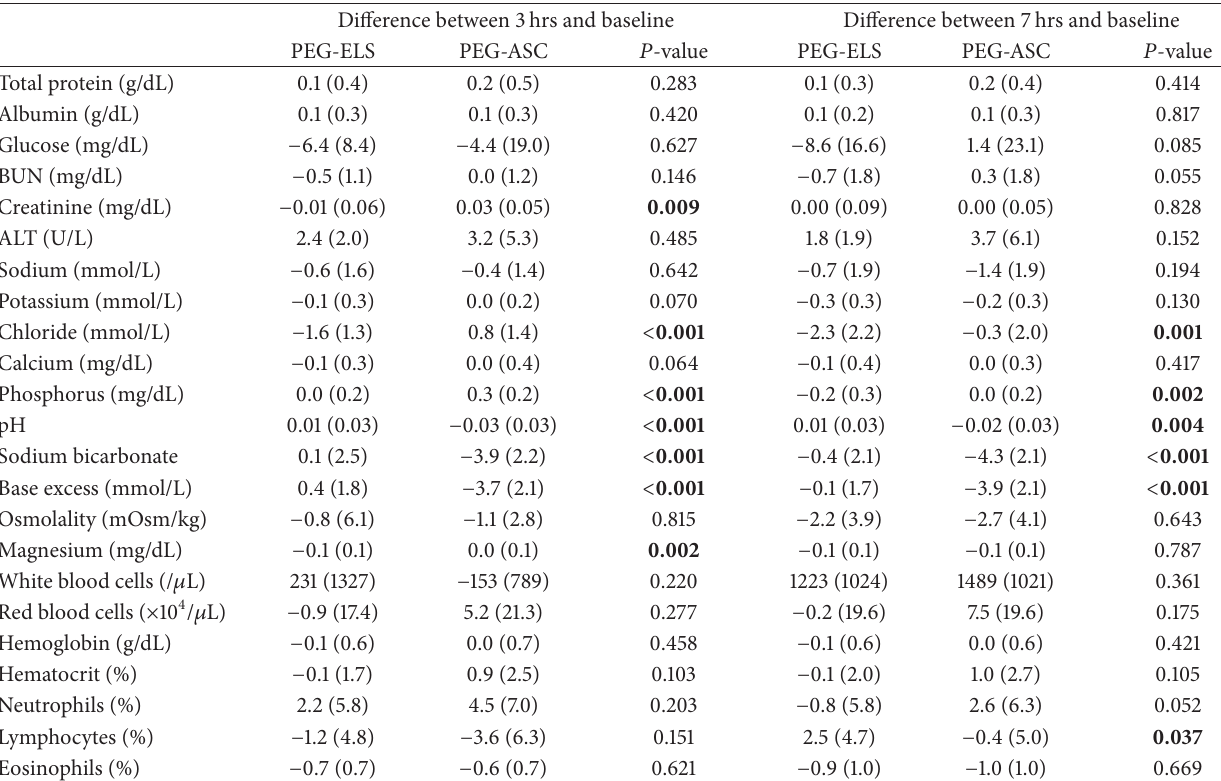
Table 6: Differences in laboratory results between baseline and 3 hours and 7 hours after taking gut lavage solution in patients aged 70 years or